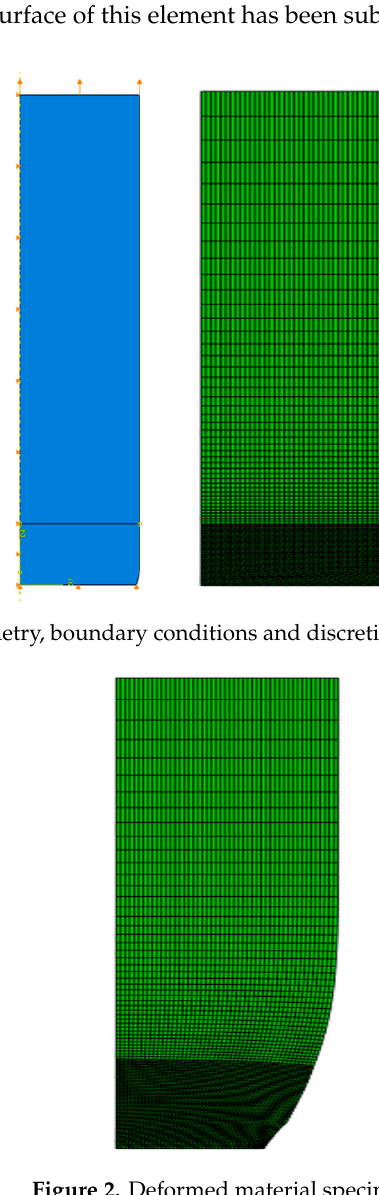
Figure 2. Deformed material specimen.